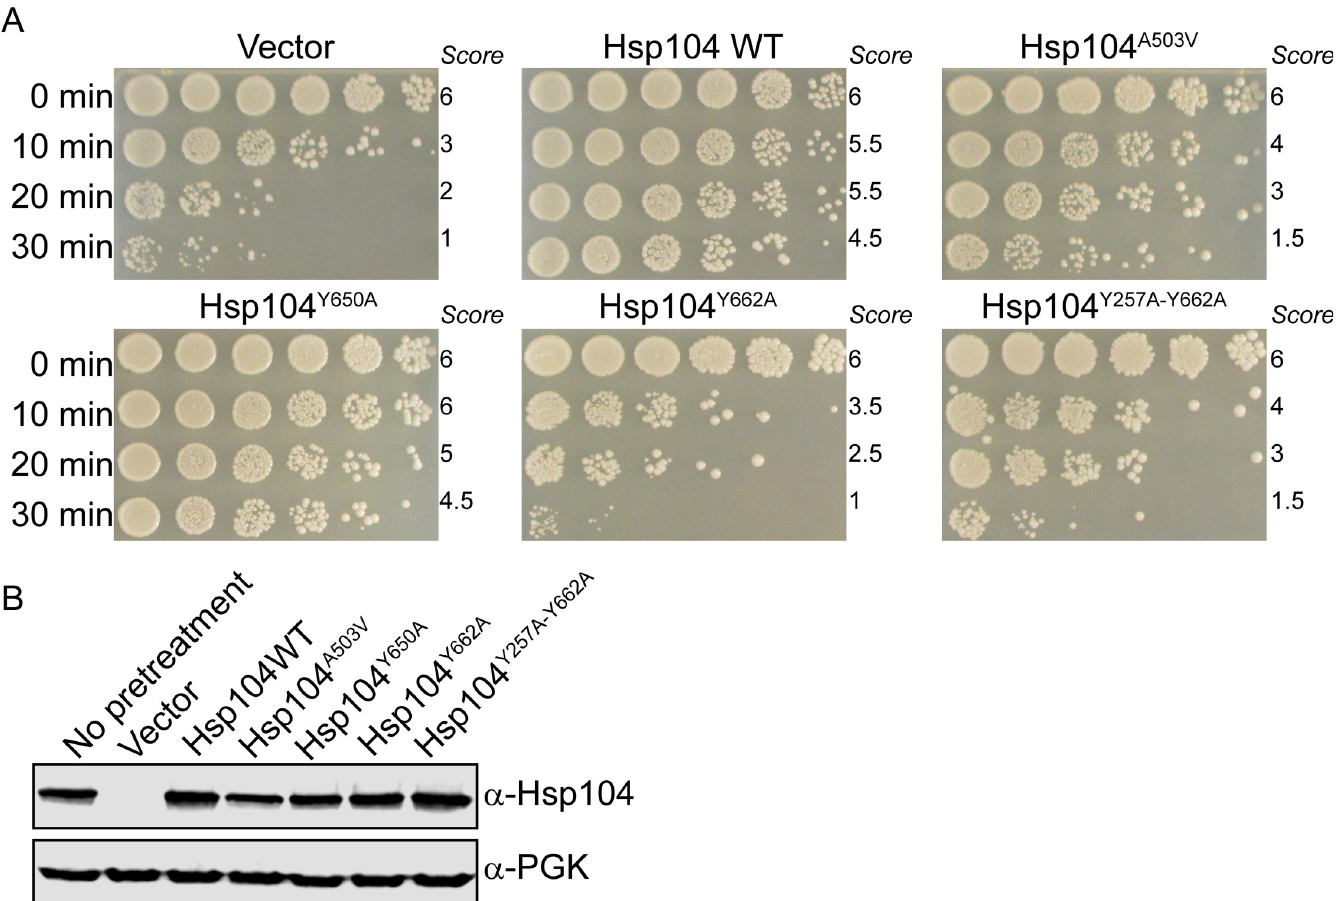
Fig 2. Ablation of substrate binding residue of putative pore loop does not abolish thermotolerance. (A) W303 Δ hsp104 yeasts were transformed with the indicated 416HSE-Hsp104 plasmid or empty vector control. Yeasts were grown to saturation, pretreated for 30min at 37˚C, subjected to 50˚C heat shock for the indicated time, serially diluted, and spotted onto SD-Ura media and incubated at 30˚C for 3 days. Scores are based on number of spots (from 1 to 6), based on an average of three biological replicates. (B) Strains from A were pretreated, lysed, and immunoblotted. 3-Phosphoglycerate kinase (PGK) serves as a loading control.